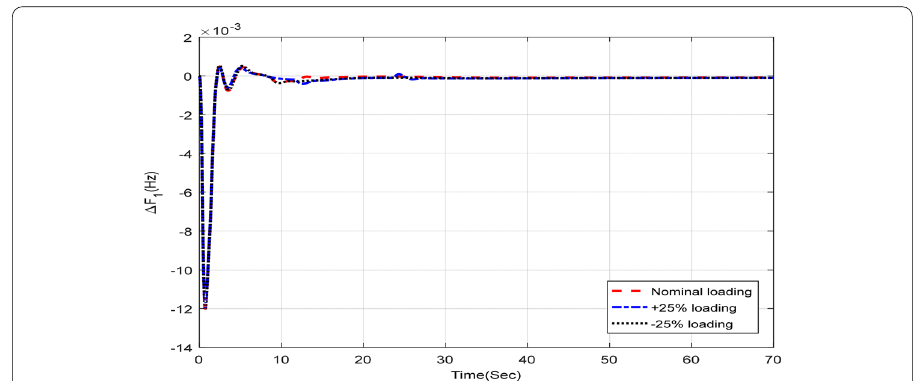
Fig. 8 ΔF 1 for variation of loading